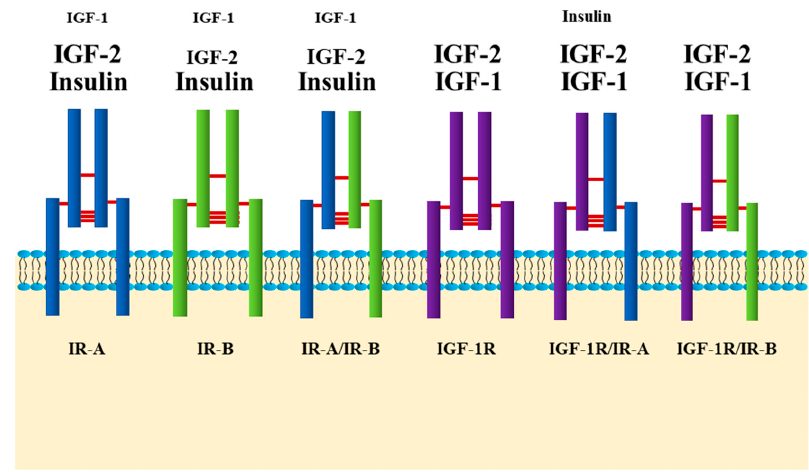
Figure 1. Insulin and insulin-like growth factor (IGF)-1 receptors. There are six types of receptors: insulin receptor (IR)-A, IR-B, IGF-1R and hybrid receptors, IR-A/IR-B, IGF-1R/IR-A and IGF-1R/IR-B. Expression of IR-A and IR-B is tissue specific. In adult life, IR-B is predominantly expressed in insulin target tissues such as liver, muscle and adipose tissue. IR-A is predominantly expressed in fetal tissues, and its expression declines during adulthood. IR-A and IR-B receptors can form hybrid receptors with each other, or along with one half of the IGF-1R. These receptors, the IGF-1R and hybrids bind the three ligands, insulin, IGF-1 and IGF-2 with di ff erent a ffi nities. This figure depicts the order of their a ffi nities to the di ff erent ligands by the size of the ligand font. Smaller font indicates lower a ffi nity, and bigger font, higher a ffi